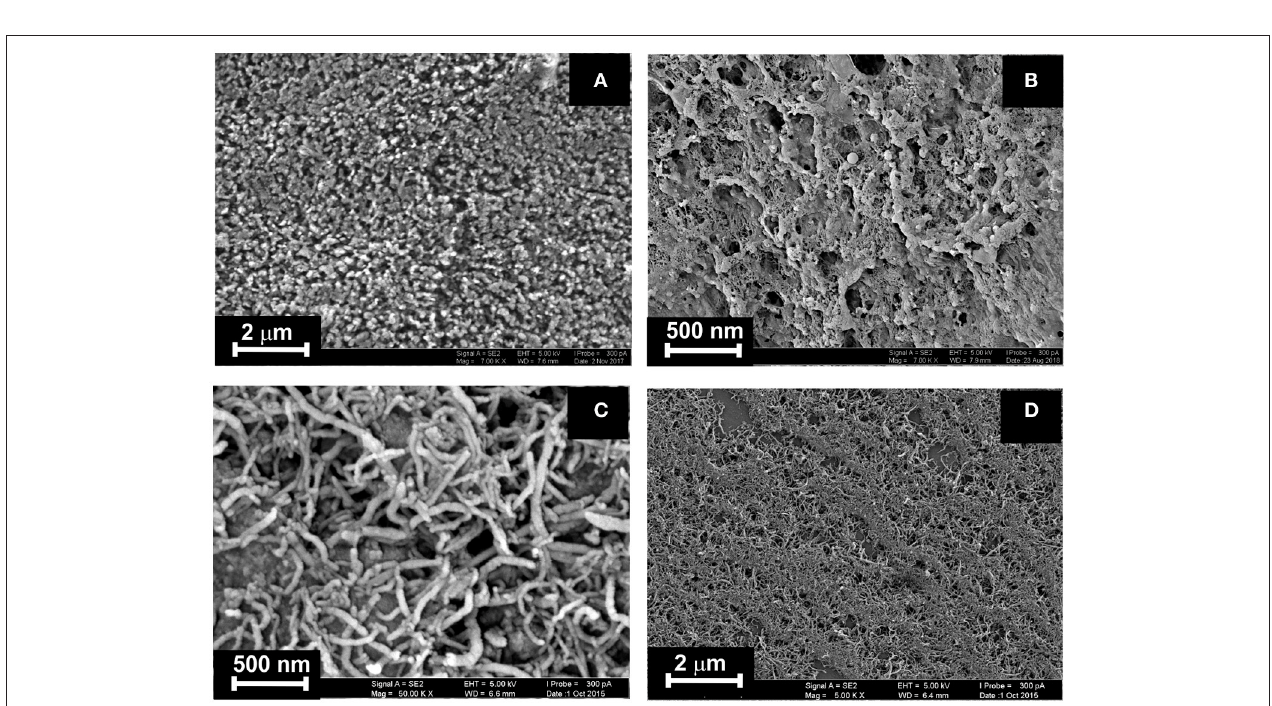
FIGURE 3 | SEM images obtained for highly oriented pyrolytic graphite covered with CB (A,B) and MWCNTs (C, D) prior to (A, C) and after deposition of IL 1 (B, D) . Layer-by-layer deposition, 0.1 mg/mL of CB and MWCNTs (aliquot 1 µ L) + 0.1mM IL 1 (aliquot 2 µ L).